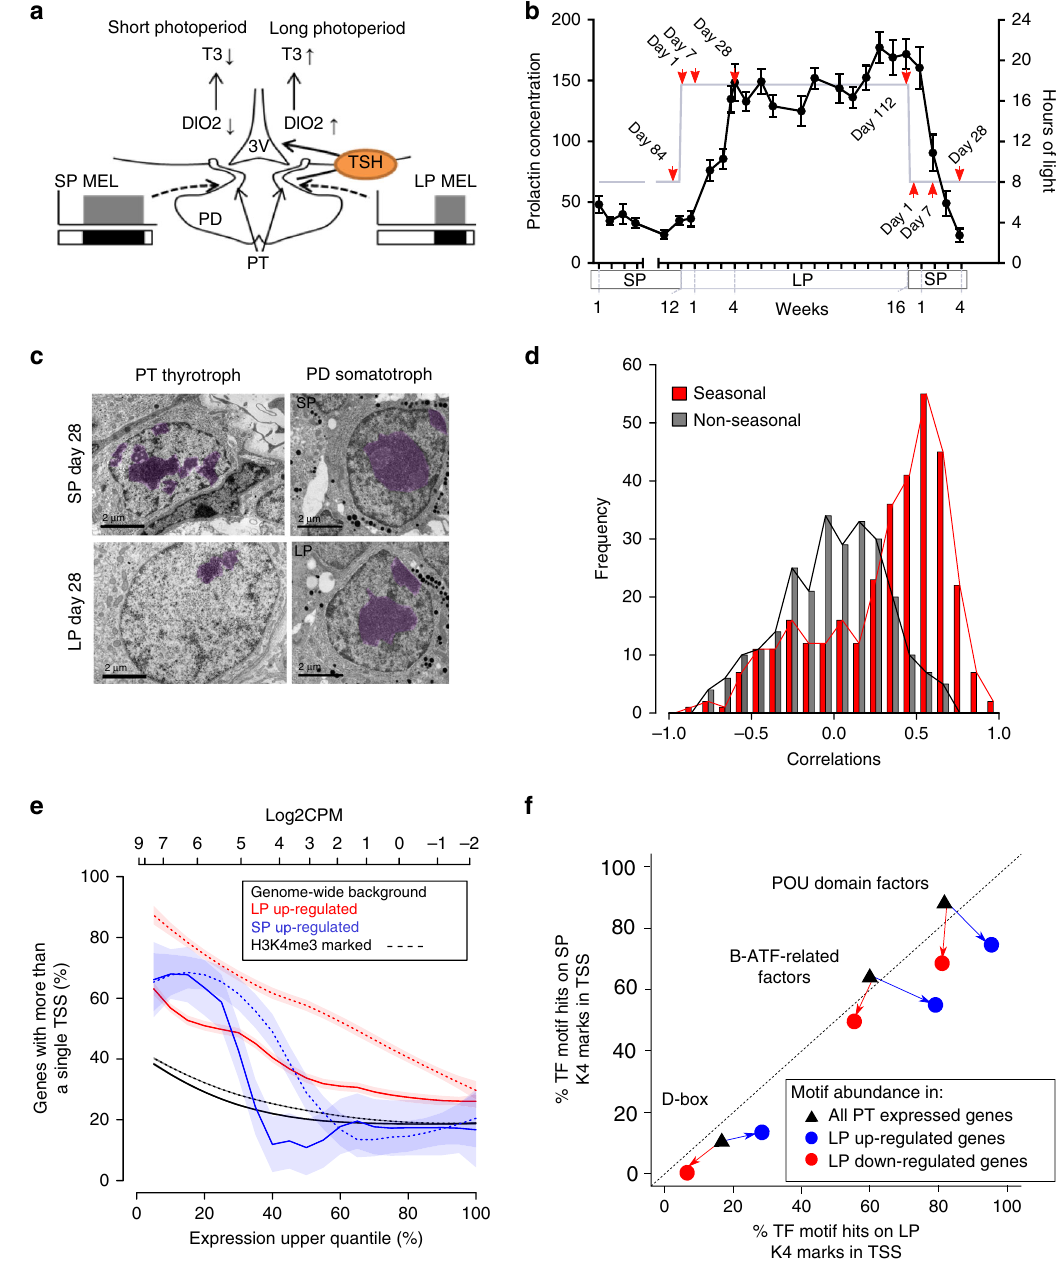
Fig. 1 Photoperiod dependent epigenetic regulation of transcription in the Pars tuberalis . a Current model for the mammalian photoperiodic circuitry. b Prolactin concentrations during the experiment (black), n = 28 biologically independent animals per time-point. Error bars represent the SEM. Gray line: number of hours of light the animals received in 24 hours. Red arrows show terminal sampling points (ZT4), with the exception of day 28 where animals were collected across the day at 4 hour intervals. c EM images of Pars tuberalis (PT) thyrotrophs and Pars distalis (PD) somatotrophs at LP day 28 and SP day 28. Dense chromatin in the nucleus is false colored in purple. Black scale bars = 2 μ m. d Histogram revealing frequency distributions of Pearson correlation coef fi cients between RNA expression (log 2 CPM) and H3K4me3 peak read counts ±200 bp from TSSs (log 2 read counts). Red bars are seasonally expressed genes (log 2 fold change ≥ 1 or ≤ − 1 and adjusted p- value <0.05 of short photoperiod (SP) day 84 vs long photoperiod (LP) day 1, 7, 28 and LP day 112 vs SP day 1, 7, 28 differentially expressed genes (DEGs) = 480) and black bars are non-seasonally expressed genes (log 2 fold change ≤ 0.1 and ≥ − 0.1 from the same comparisons, (genes = 218)). e Prevalence of multiple (>1) TSSs in LP day 28 up-regulated DEGs (solid red), SP day 28 up- regulated DEGs (solid blue) and all PT expressed genes as the background (solid black) as a percentage of the uppermost expressed genes (i.e., increasing thresholds for the upper quantile of gene expression). Log 2 CPM values for upper quantiles on upper x-axis. Dashed lines indicate the proportion of gene in the cohorts with multiple H3K4me3 (>1) marked TSS. f Over-represented motifs LP day 28 up and down-regulated genes, compared to SP day 28. The percentage of H3K4me3 marked TSS (±100 bp) containing a speci fi c motif is given. The black triangles represents the motif abundance in all the genes expressed (>0 CPM) in the PT and the percentage of marked with H3K4me3 in LP ( x -axis) or SP ( y -axis). The circles show the motif abundance and percentage H3K4me3 marked TSSs in LP up-regulated (blue) and down-regulated (red) genes (FDR <0.05; fi shers two-way exact